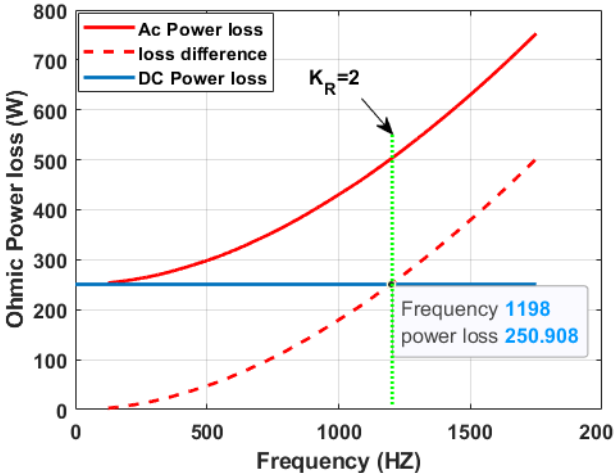
Figure 7. The FEA temperature map of the considered surface PMSM.